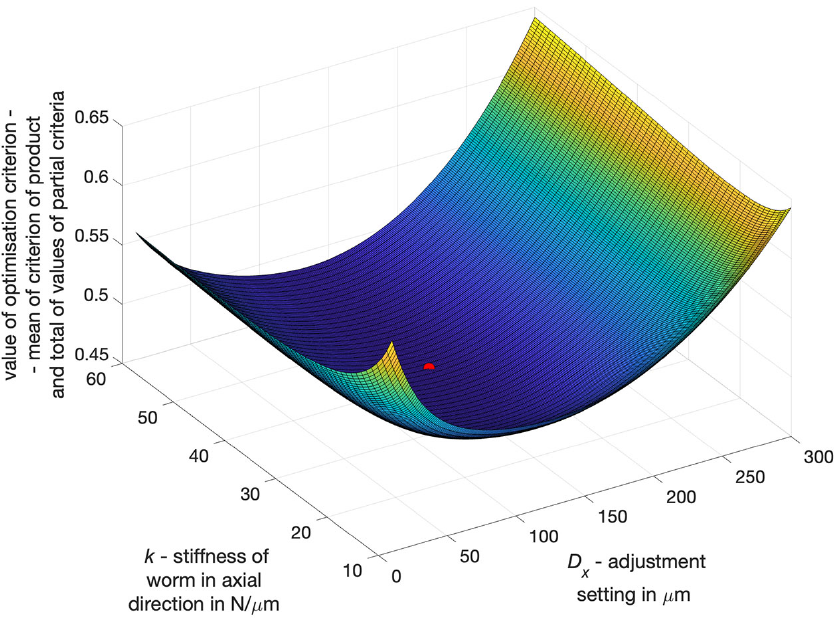
Figure 22. Result of multi-criteria selection of worm axial stiffness and adjustment setting for a specific worm gear